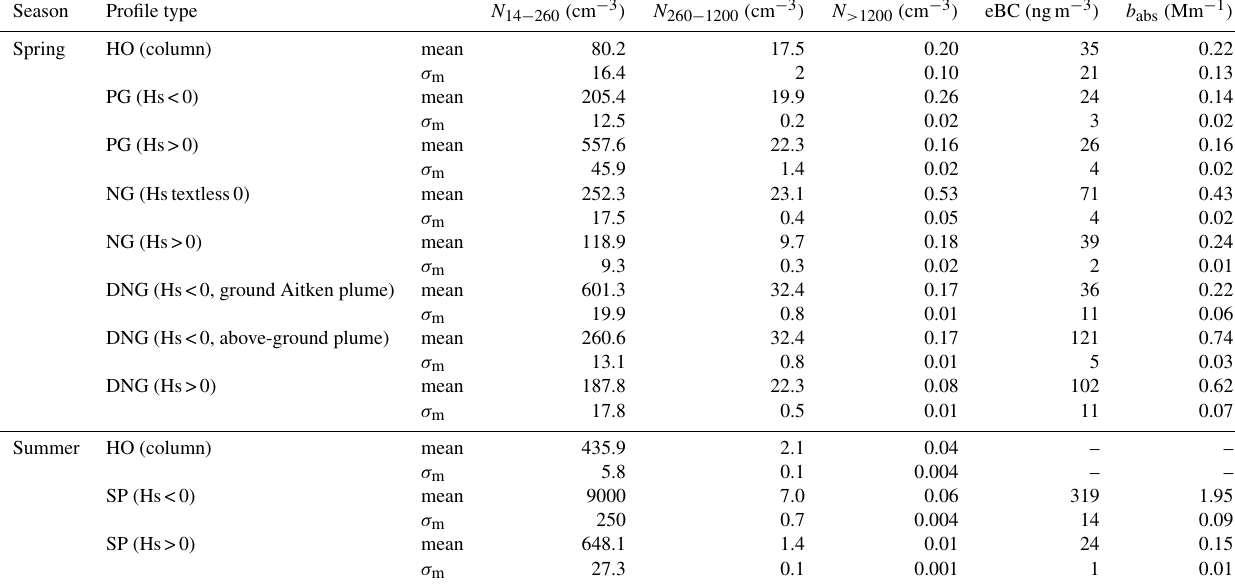
Table 3. Average concentrations of N 14 − 260 , N 260 − 1200 , N > 1200 , eBC and b abs along height over Ny-Ålesund for the springtime and summertime typologies of vertical